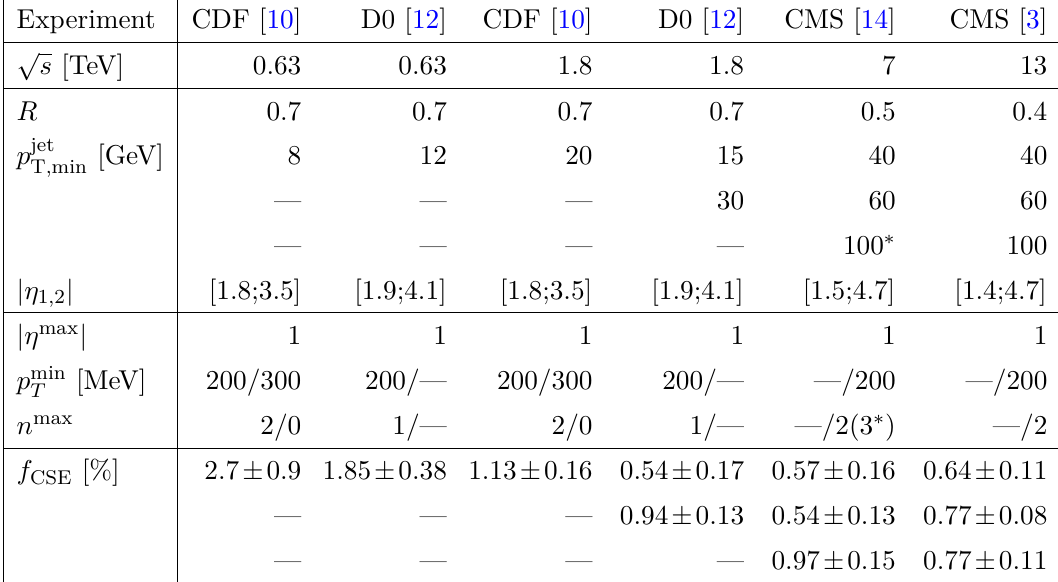
Table 2 . Experimental conditions and results of jet-gap-jet event measurements of the CDF [10] and D0 [12] experiments at the Tevatron and of the CMS experiment [3, 14] at the LHC for different √ center-of-mass energies , jet pseudorapidi- s , jet sizes R , subleading jet transverse momenta p jet2 T ties η ( η 0 ), gap size η max , calorimeter/track neutral/charged particle threshold p min and 1 , 2 1 η 2 < T multiplicity n max , and observed fraction of CSE events f . The * symbol is to stress that at CSE 7 TeV, a maximum of n max = 3 were used for the p jet2 > 100 GeV T